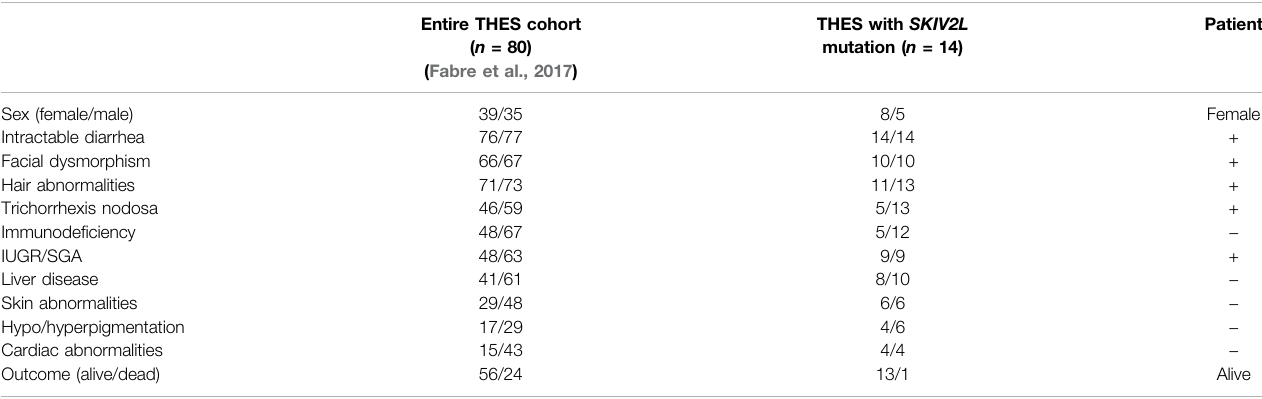
TABLE 2 | Comparison of clinical features of the proband with a large cohort of patients with